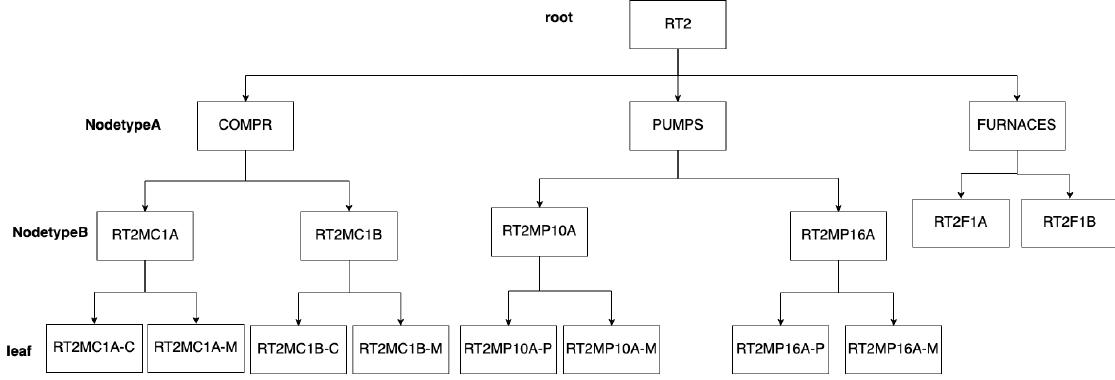
Figure 2. Subset of the component